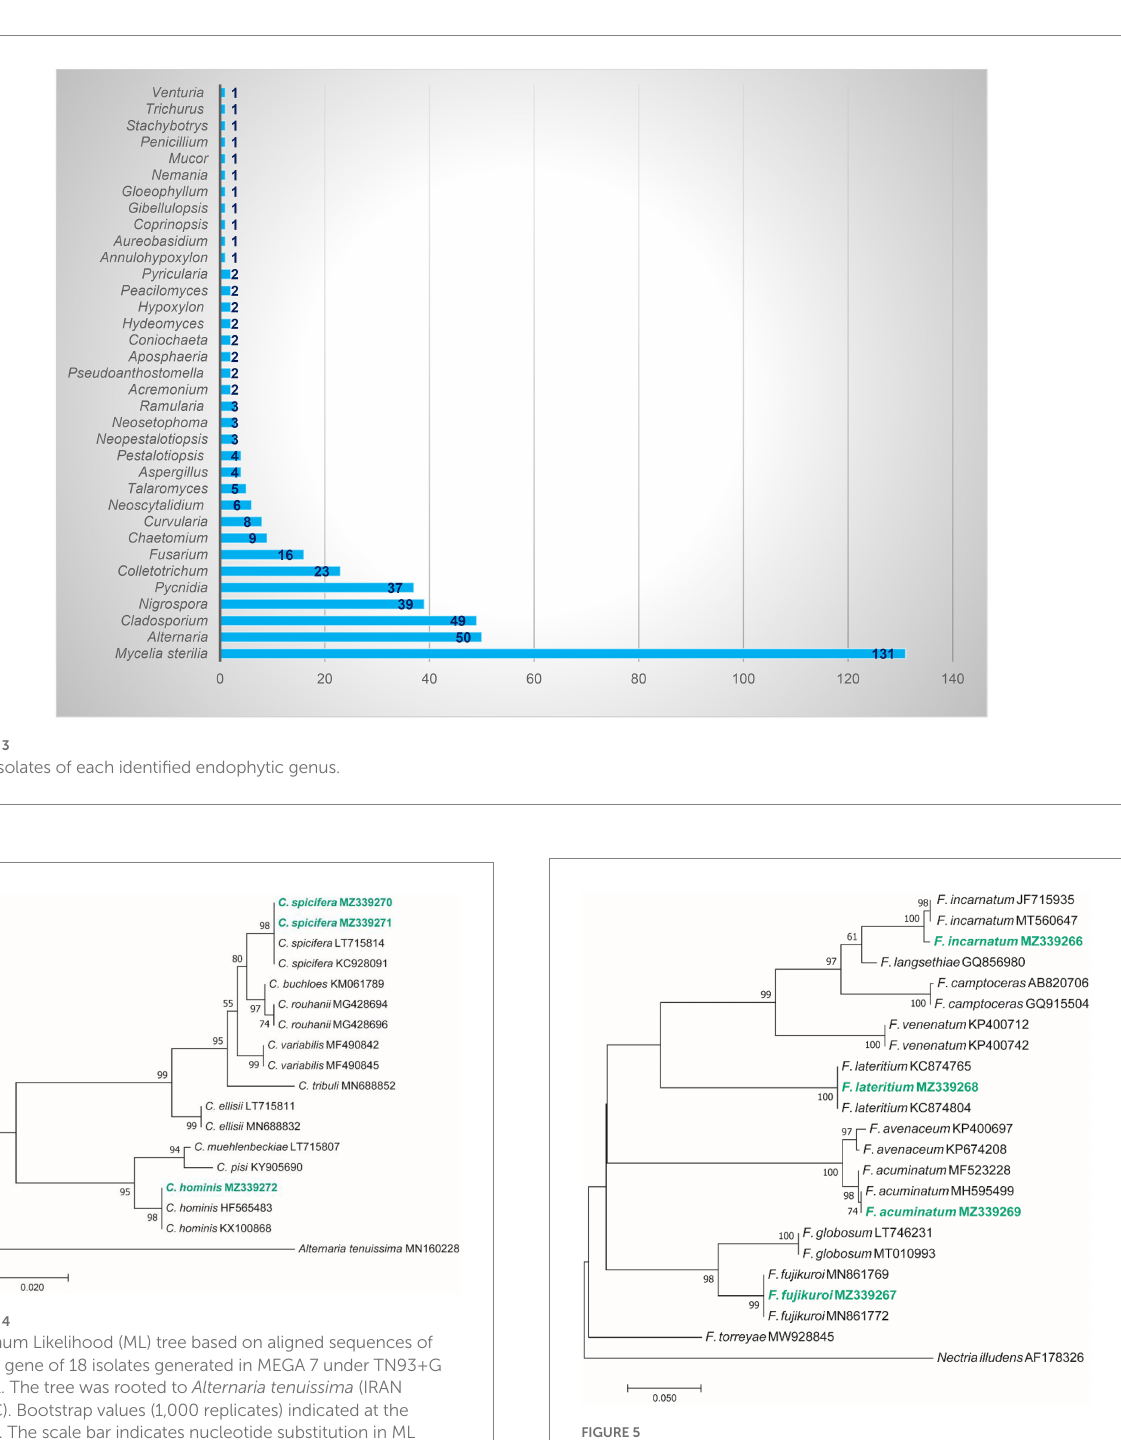
FIGURE 4 Maximum Likelihood (ML) tree based on aligned sequences of gapdh gene of 18 isolates generated in MEGA 7 under TN93 + G model. The tree was rooted to Alternaria tenuissima (IRAN 2428C). Bootstrap values (1,000 replicates) indicated at the nodes. The scale bar indicates nucleotide substitution in ML analysis, values ≥ 50% are shown above/below the branches. The surveyed isolates in the current study are highlighted in bold.